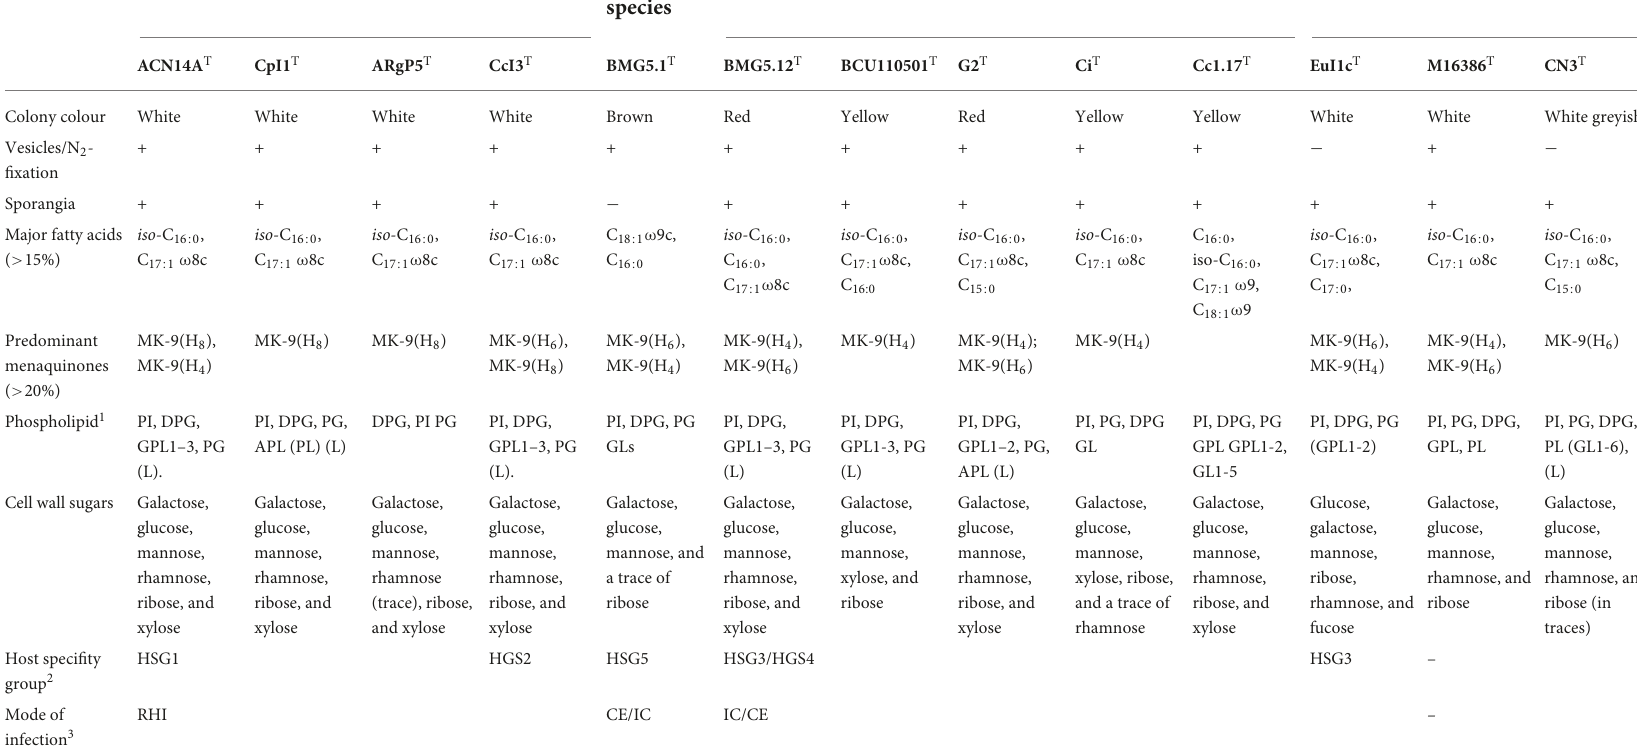
TABLE 2 Phenotypic and host-plant-related